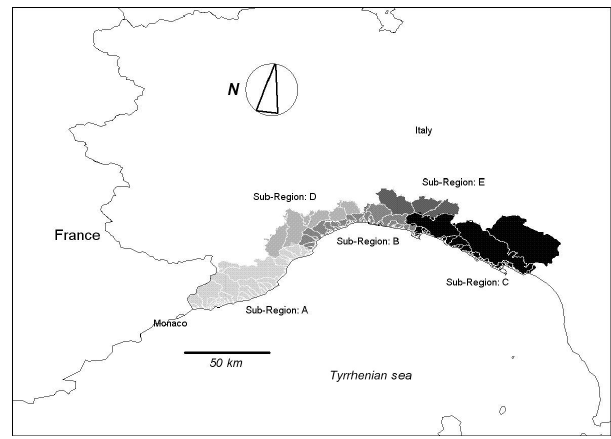
Figure 2. Study area. In different grey tones the five alert sub-regions of Liguria are shown, together with the watershed of the main basins. 3